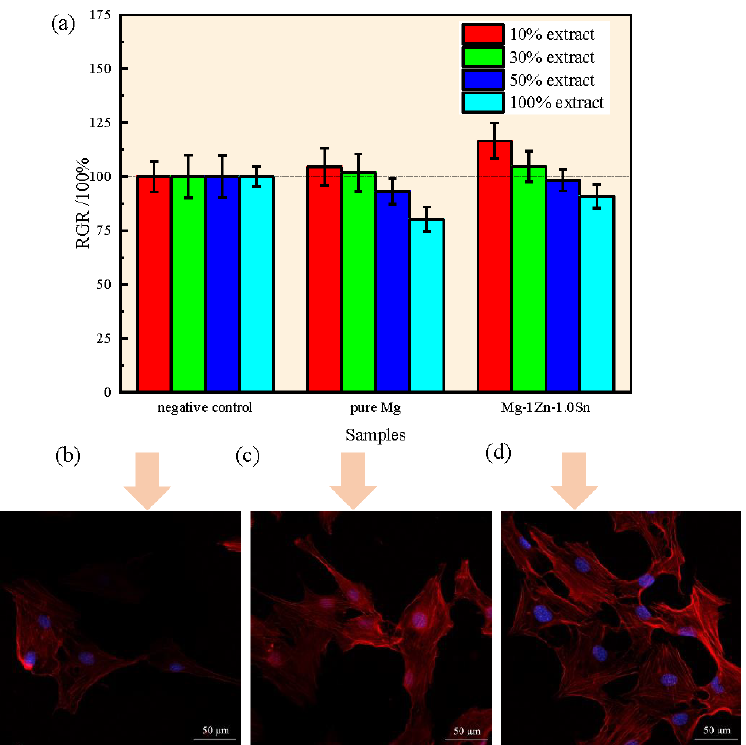
Figure 9. MC3T3-E1 cells viability ( a ) in solutions containing different concentrations of extract incubated for 72 h by CCK-8 method, and the corresponding cells co-cultured after 24 h incubation with negative control ( b ), pure Mg ( c ), and Mg-1Zn-1.0Sn ( d ) characterized by CLSM.